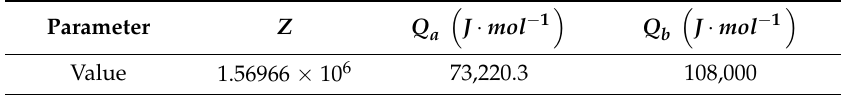
Table 3. The physical parameters for 5754 aluminium alloy obtained by regression and used in this